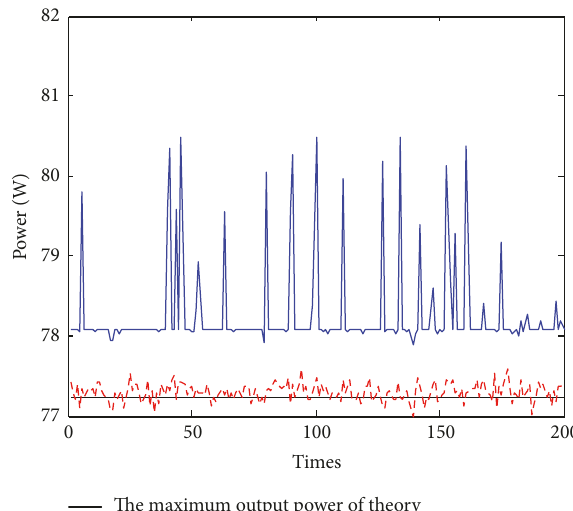
Figure 6: Comparison of tracking results.